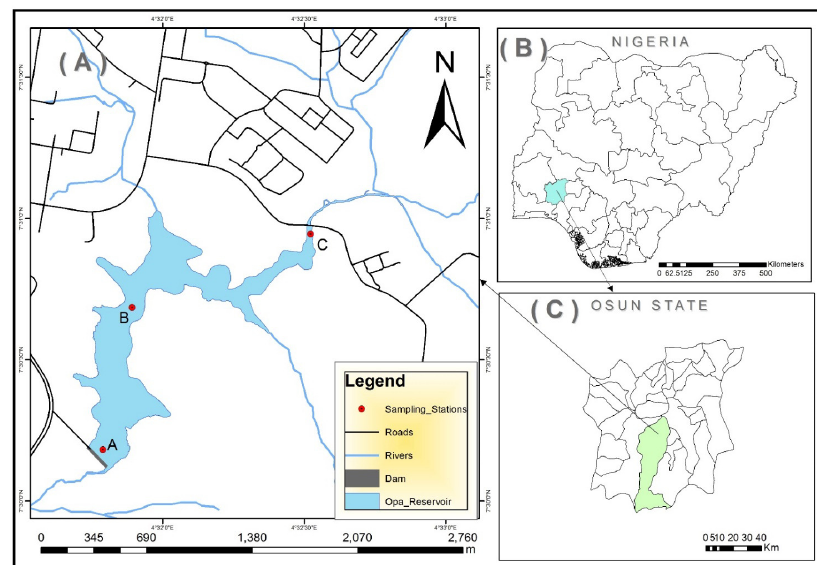
Fig. 1. Map of Opa Reservoir showing the sampling